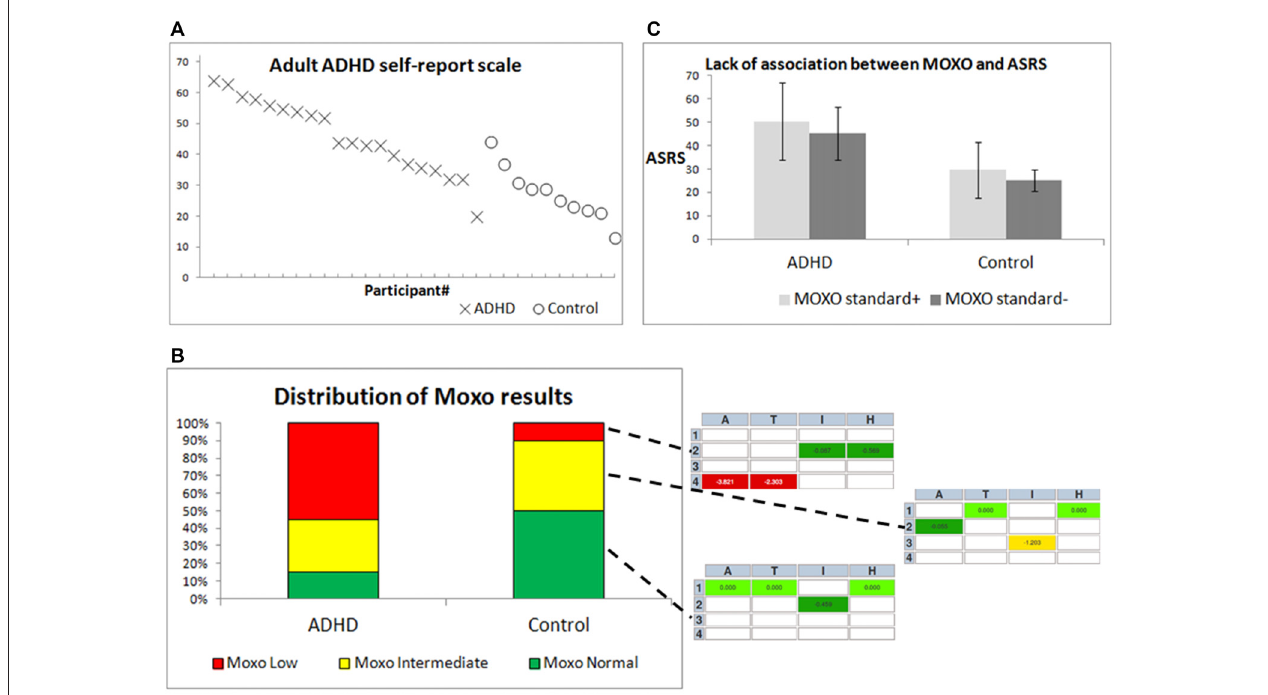
FIGURE 3 | Differentiation between ADHD patients and controls by behavioral diagnostic tools. (A) ASRS scores for individual participants, ordered by group and by ASRS score. X = ADHD patients, O = controls. (B) The right inset from three MOXO reports includes four indices: attention [A], timing [T], impulsiveness [I] and hyperactivity [H]. Each index is color-coded in the report: green indicates standard or above-standard performance, yellow indicates intermediate performance and red indicates difficulty in performance. (C) Means ± standard deviations of ASRS scores for both groups, with distinction between MOXO standard+ and MOXO standard −